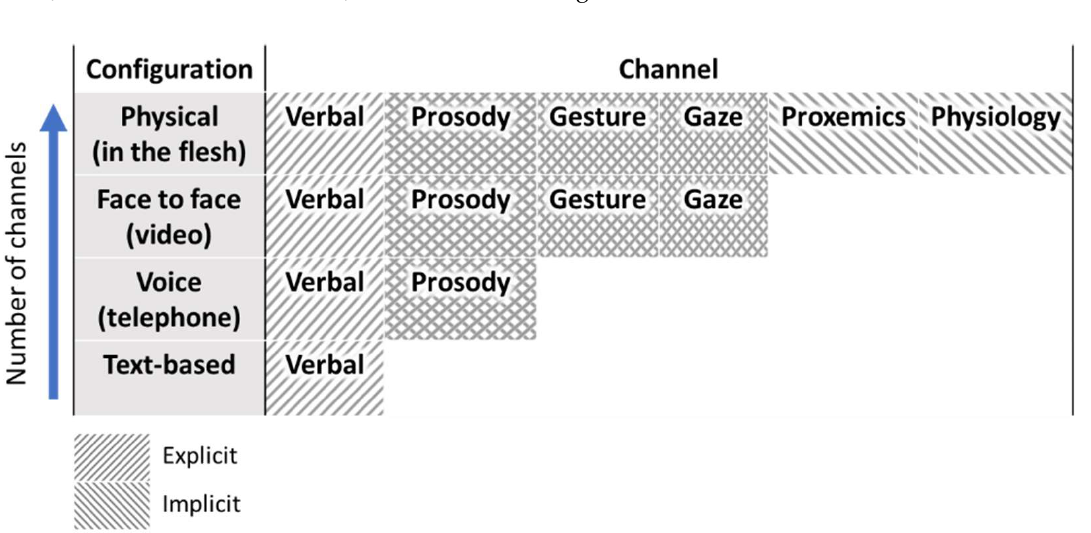
Figure 3. Overview of the relationship between communication configuration, number of channels, and channel properties. The number of channels decreases from physical world interaction to video-calling to voice-calling to texting.